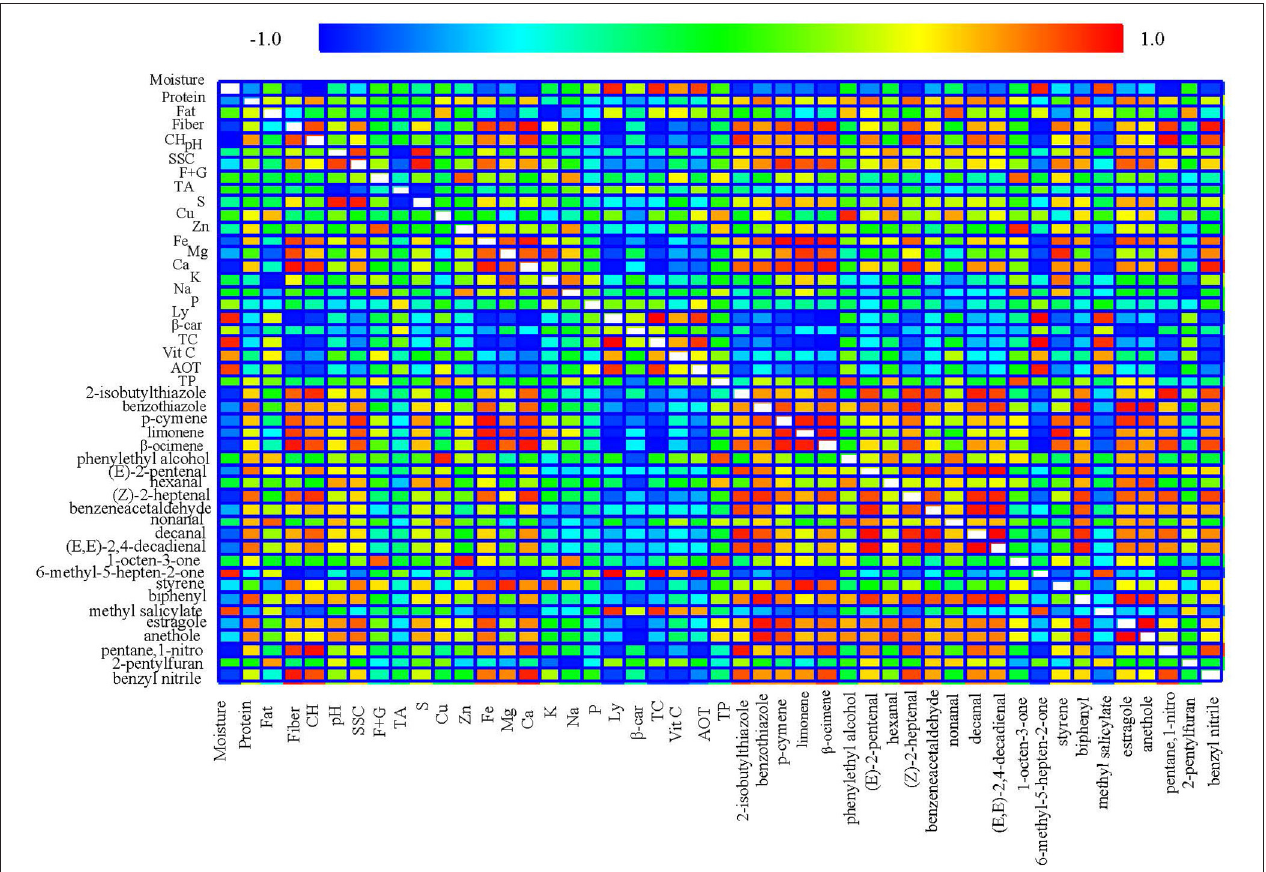
FIGURE 2 | Pearson linear correlations between the traits (nutritional and volatile) studied for the data obtained in the two Malacara tomatoes (yellow and red cv). A positive trend between each pair of variables (red color), a negative trend between each pair of variables (blue color), and no relationship between each pair of variables (green color). The strongest positive/negative relationships are displayed with the greatest intensity of